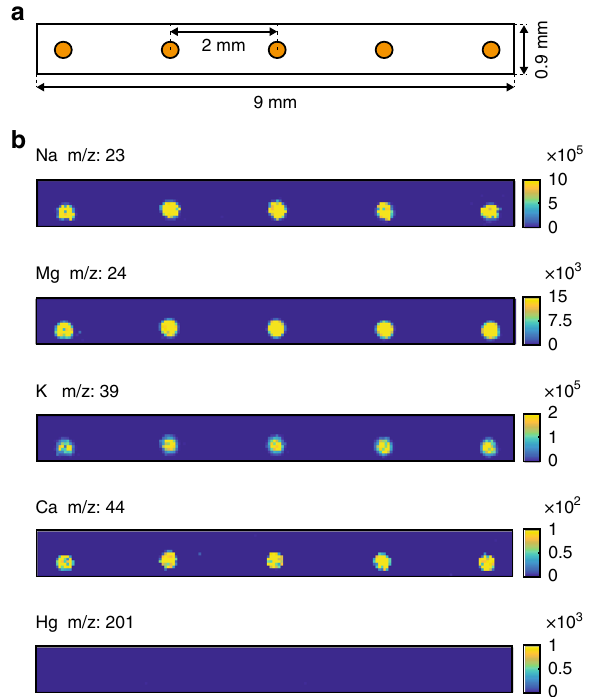
Fig. 3 Brain- fl uid samples imaging after LA-ICP-MS analysis. a Samples con fi guration prior to analysis. The parylene base plate includes fi ve brain- fl uid samples (orange spots) distributed along the substrate. b Relative abundance (a.u.) of the elements Na, Mg, K, Ca, and Hg (negative